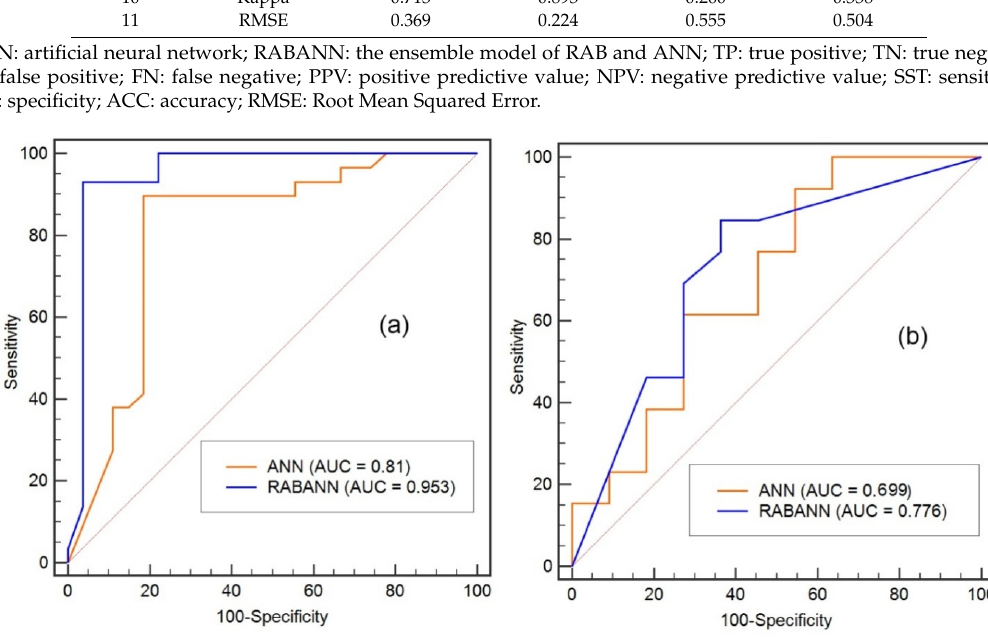
Table 2. Training and validation performances of the models.